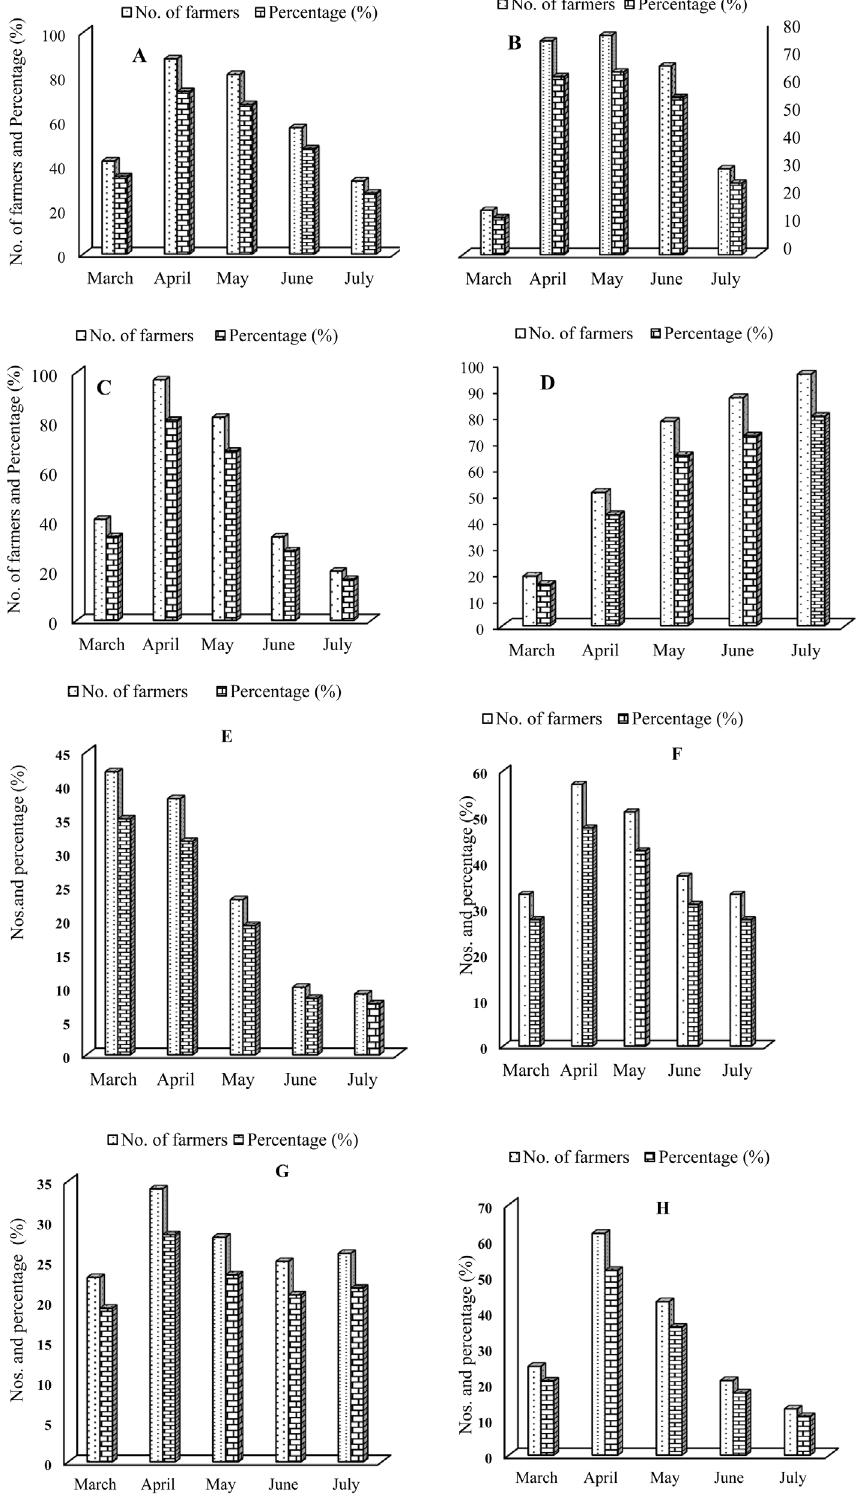
Fig. 3. Constraints faced by the farmers during COVID-19 in Site-FW (A (cid:2) Transport; B (cid:2) Crisis of labourer; C (cid:2) Seed availability; D (cid:2) Social distancing; E (cid:2) Police action in enforcing lock-down; F (cid:2) Harvesting; G (cid:2) Input availability and, H (cid:2) Marketing) in different months.